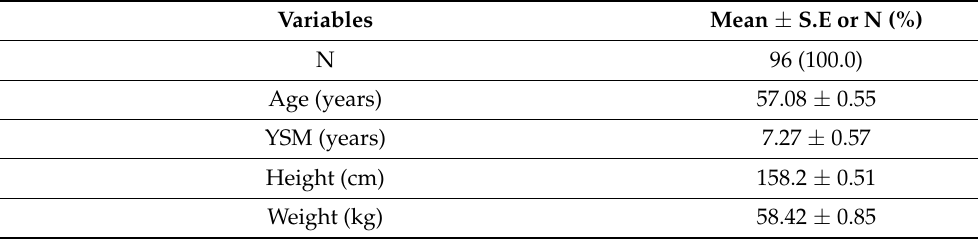
Table 1. General characteristics and lifestyle of the